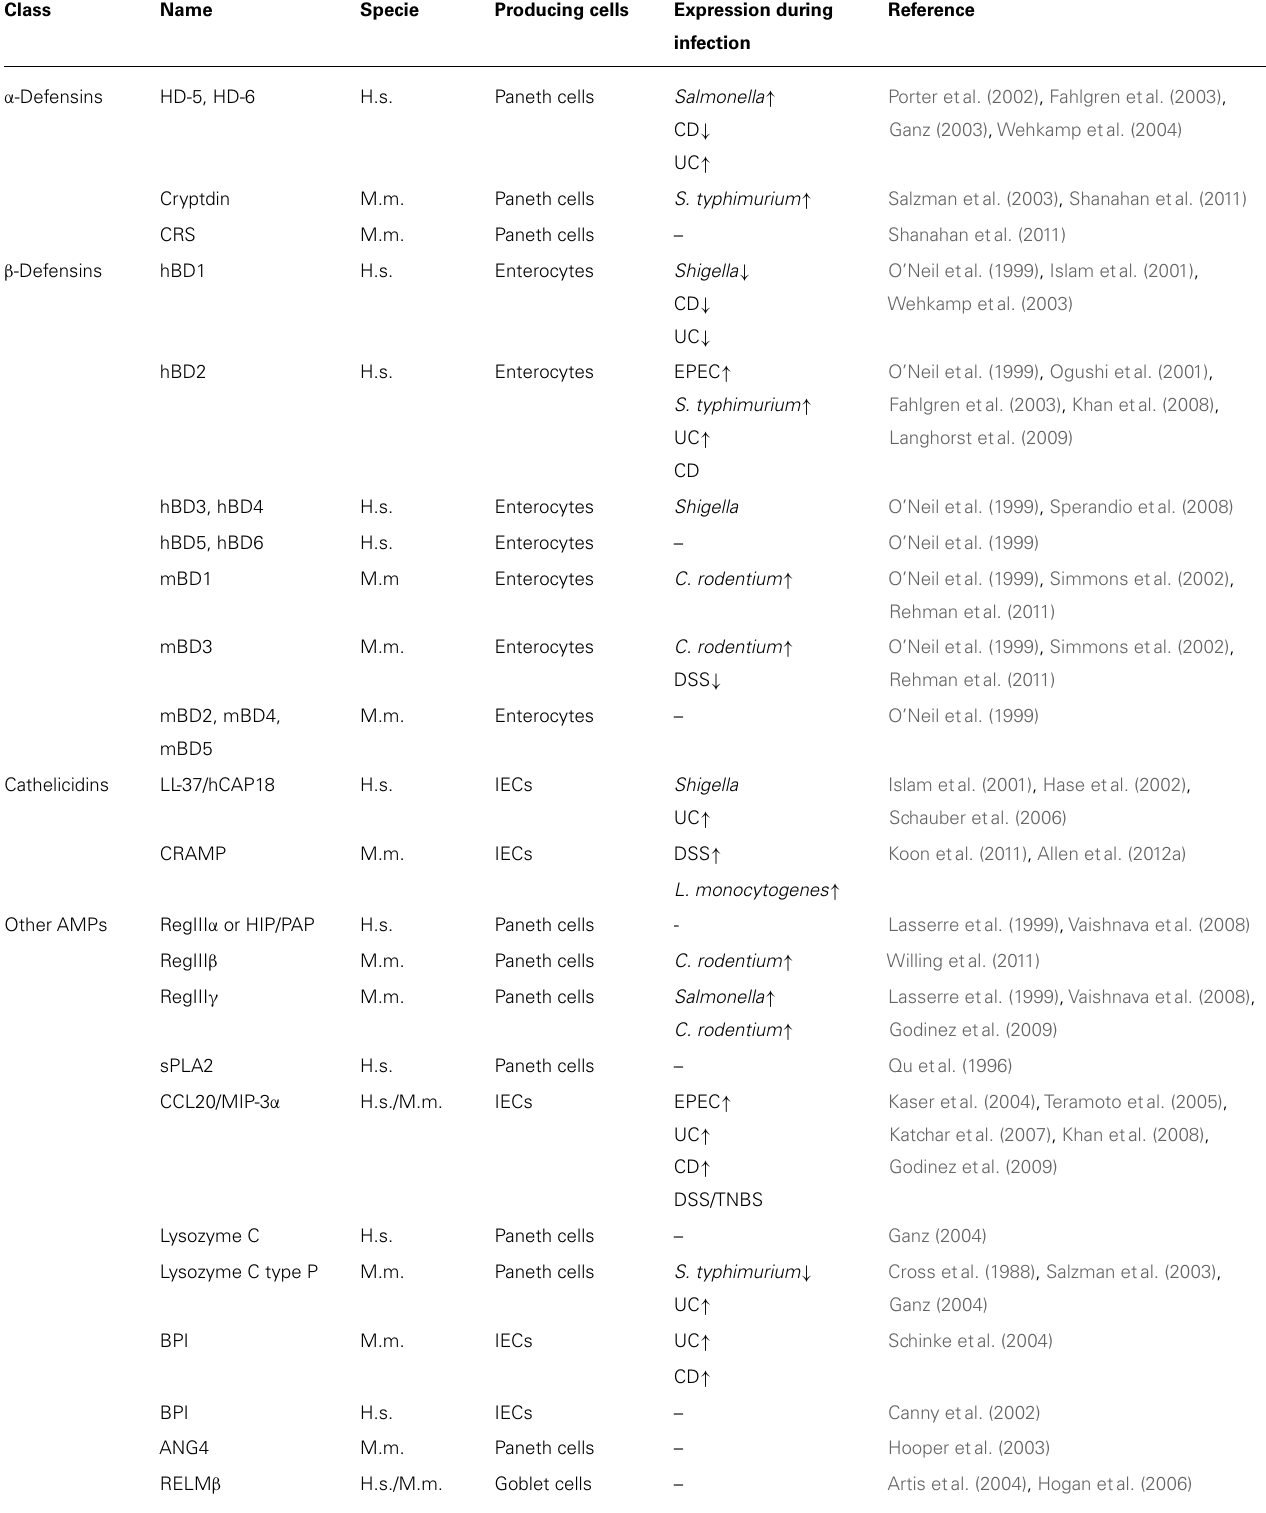
Table 1 | Human and mouse intestinal antimicrobial peptides and their expression during infection and intestinal